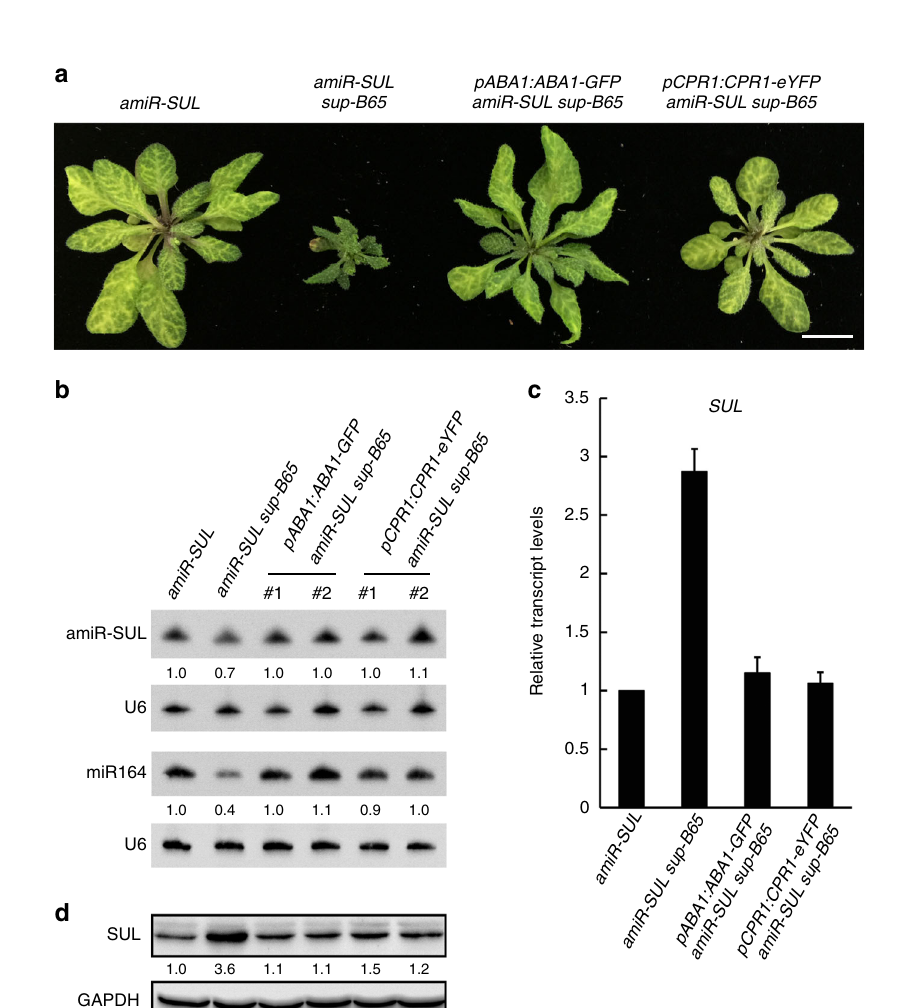
Fig. 2 Simultaneous mutations in CPR1 and ABA1 cause the phenotypes of amiR-SUL sup-B65 . a Plants of the indicated genotypes. amiR-SUL sup-B65 plants were transformed with pCPR1:CPR1-eYFP or pABA1:ABA1-GFP . Either transgene fully rescued the morphological defects of amiR-SUL sup-B65 . Bar = 1 cm. b Northern blots to determine the abundance of amiR-SUL and an endogenous miRNA in plants of the indicated genotypes. Two independent transgenic lines of pCPR1:CPR1-eYFP and pABA1:ABA1-GFP were used. U6 served as the internal control. The numbers indicate relative abundance of the miRNAs. c Relative transcript levels of the amiR-SUL target gene SUL in the indicated genotypes as determined by quantitative RT-PCR. The levels of SUL transcript in amiR-SUL sup-B65 were restored to those in amiR-SUL by either the pCPR1:CPR1-eYFP or pABA1:ABA1-GFP transgene. Error bars represent standard deviations calculated from three biological replicates. d Western blots to determine SUL protein levels in plants of the same genotypes as in b . GAPDH served as a loading control. SUL protein levels were elevated in amiR-SUL sup-B65 but restored by either pCPR1:CPR1-eYFP or pABA1:ABA1-GFP in two independent transgenic lines. Source data are provided as a Source Data fi le (Fig. 2c) and SUL protein (Fig. 2d), to wild-type levels. Moreover, either transgene rescued the defect in miR164 accumulation in the amiR-SUL sup-B65 mutant (Fig. 2b). Therefore, the miRNA biogenesis and plant size defects of amiR-SUL sup-B65 were attributable to a combination of cpr1 – 4 and aba1 – 8 . For simplicity, we thereafter refer to the double mutant cpr1 – 4 aba1 – 8 as cpr1 aba1 . cpr1 aba1 and wild type by northern blotting. All of them showed